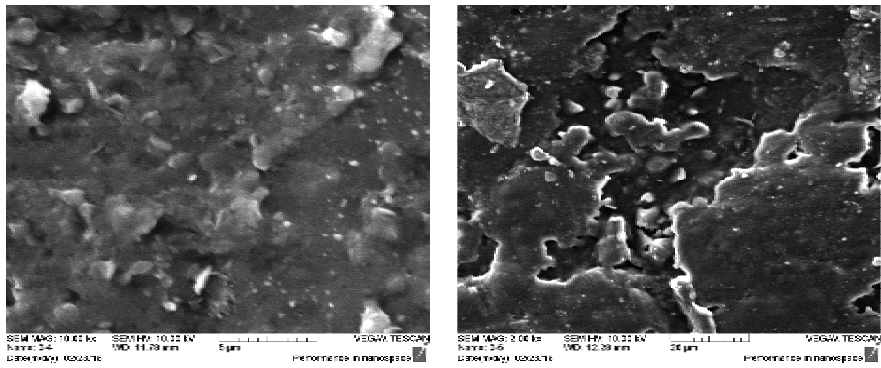
Fig. 3. SEM test for standard